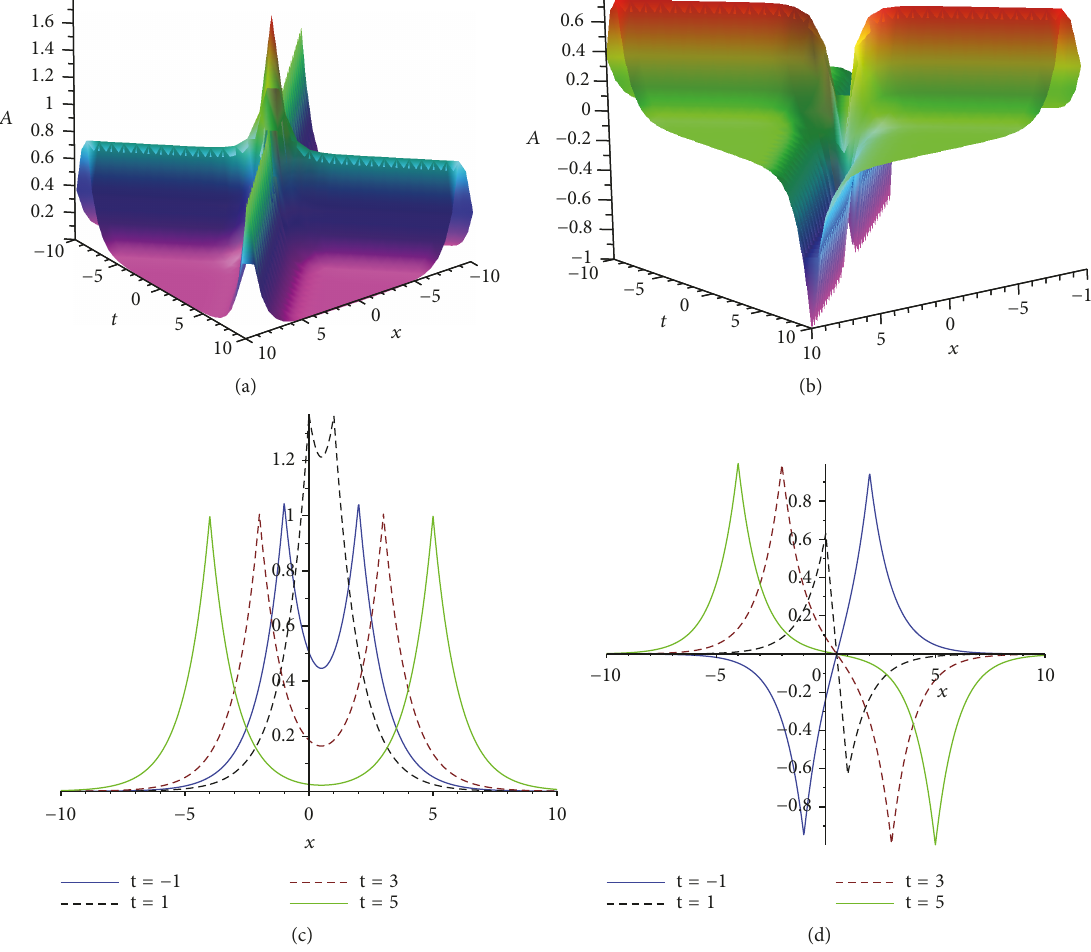
Figure 2: (Colored online) The two-peakon solution of (9). (a) 3D-plot for 𝐴(𝑥,𝑡) when 𝑝 1 = 1,𝑝 2 = 1,𝑥 0 = 0, 𝑞 1 = −𝑡 + 1,𝑞 2 = 𝑡 . (b) 3D-plot for 𝐴(𝑥,𝑡) when 𝑝 1 = 1,𝑝 2 = −1,𝑥 0 = 0,𝑞 1 = −𝑡 + 1,𝑞 2 = 𝑡 . (c, d) Plot for 𝐴(𝑥,𝑡) when 𝑡 = −1,𝑡 = 1,𝑡 = 3,𝑡 = 5 .